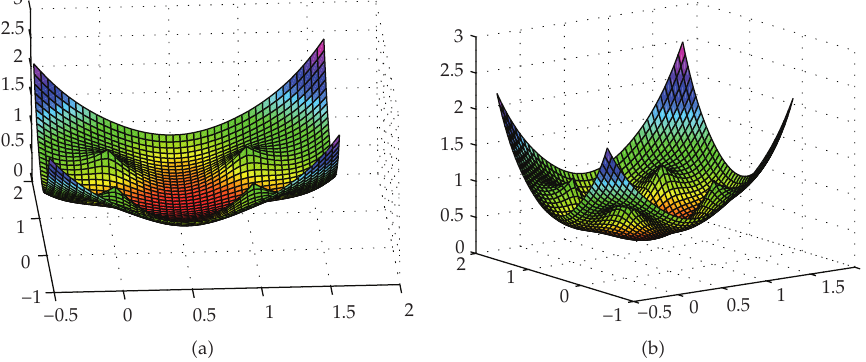
Figure 3: Two di ff erent perspectives of objective function for first case of Example 4.2.